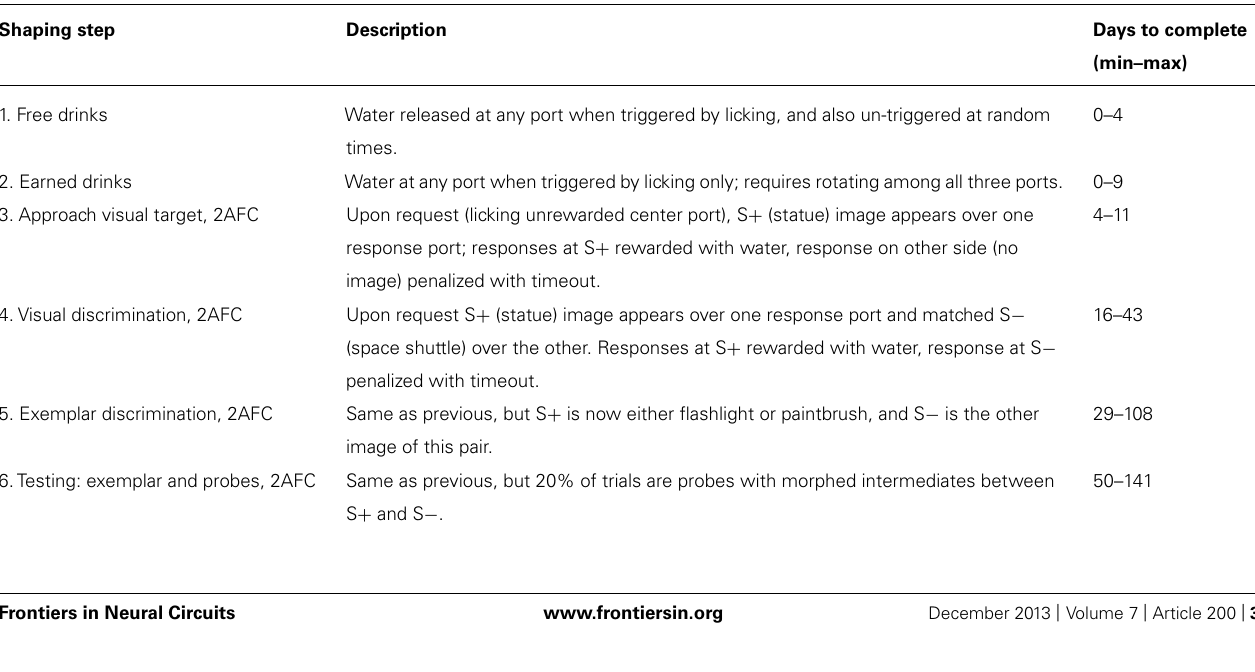
Table 1 | Details of shaping sequence for task